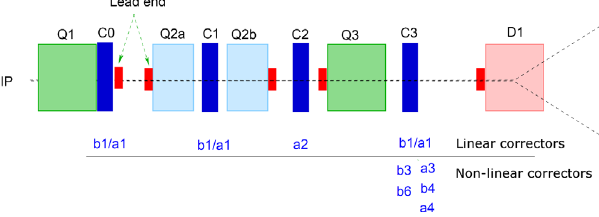
FIG. 4. Linear and nonlinear corrector layout in LHC exper- imental IRs